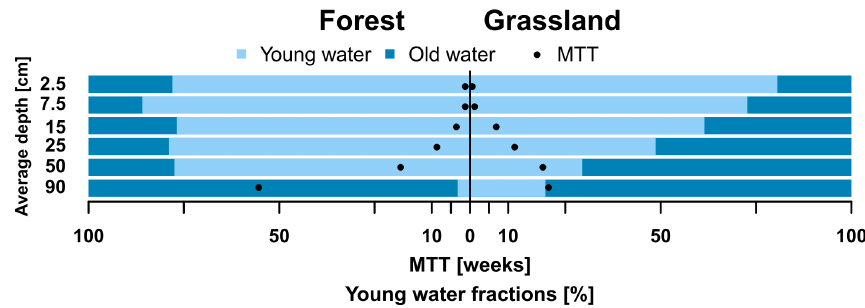
Figure 6. Young water fractions (bars) and MTT (dots) per soil depths at forested and grassland sites.